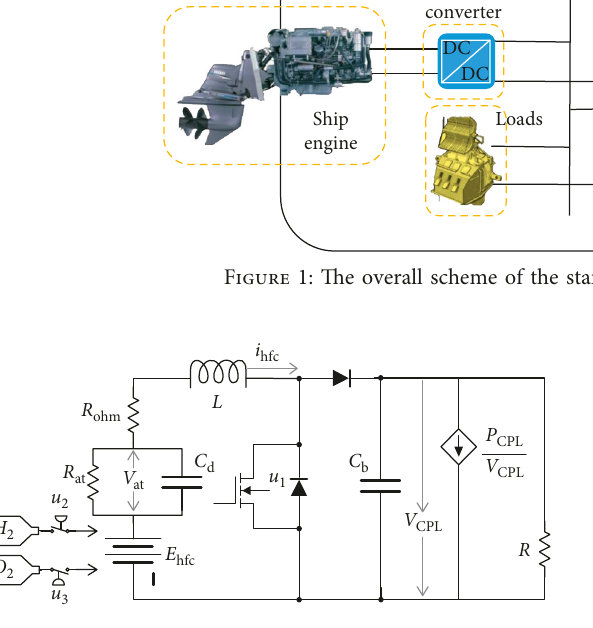
Figure 2: Circuit diagram of the marine DC MG with a fuel cell and a CPL.